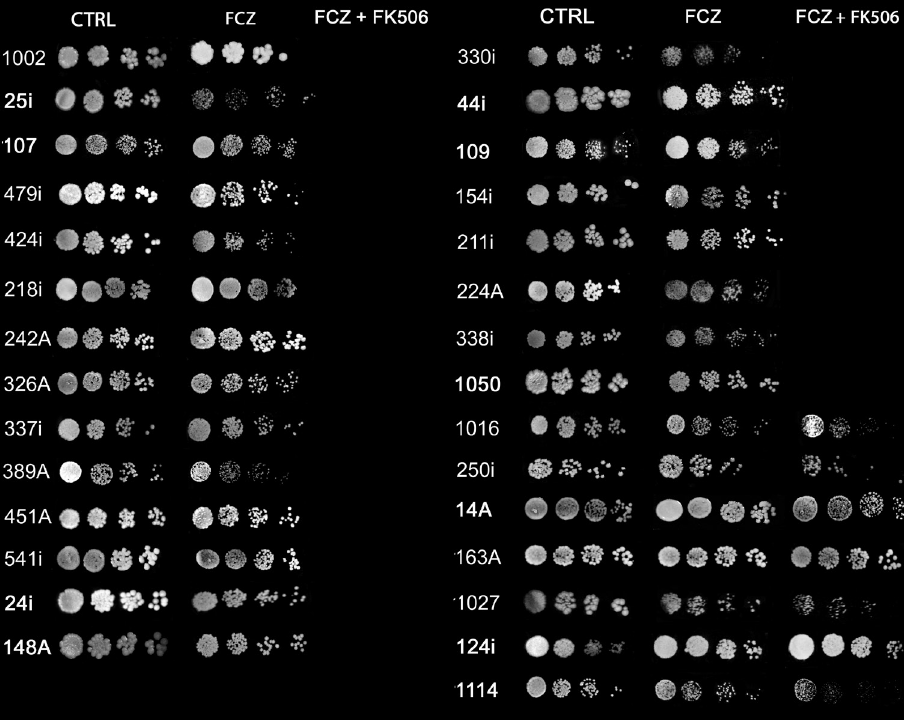
Figure 3 - Evaluation of FCZ reversion by FK506 on 29 resistant Candida spp. clinical strains. CTRL: yeast cells growth on Sabouraud solid medium in absence of FCZ for 48h. FCZ (+): yeast cell growth on Sabouraud solid medium containing 64µg/mL of FCZ. FCZ(+) and FK506: yeast growth in same conditions as CTRL plus FCZ (+) presenting FK506 10μM. Most clinical strains presented resistance reversion using FK506, a classic ABC transporter inhibitor. Only seven strains were still resistant to FCZ even in the presence of the